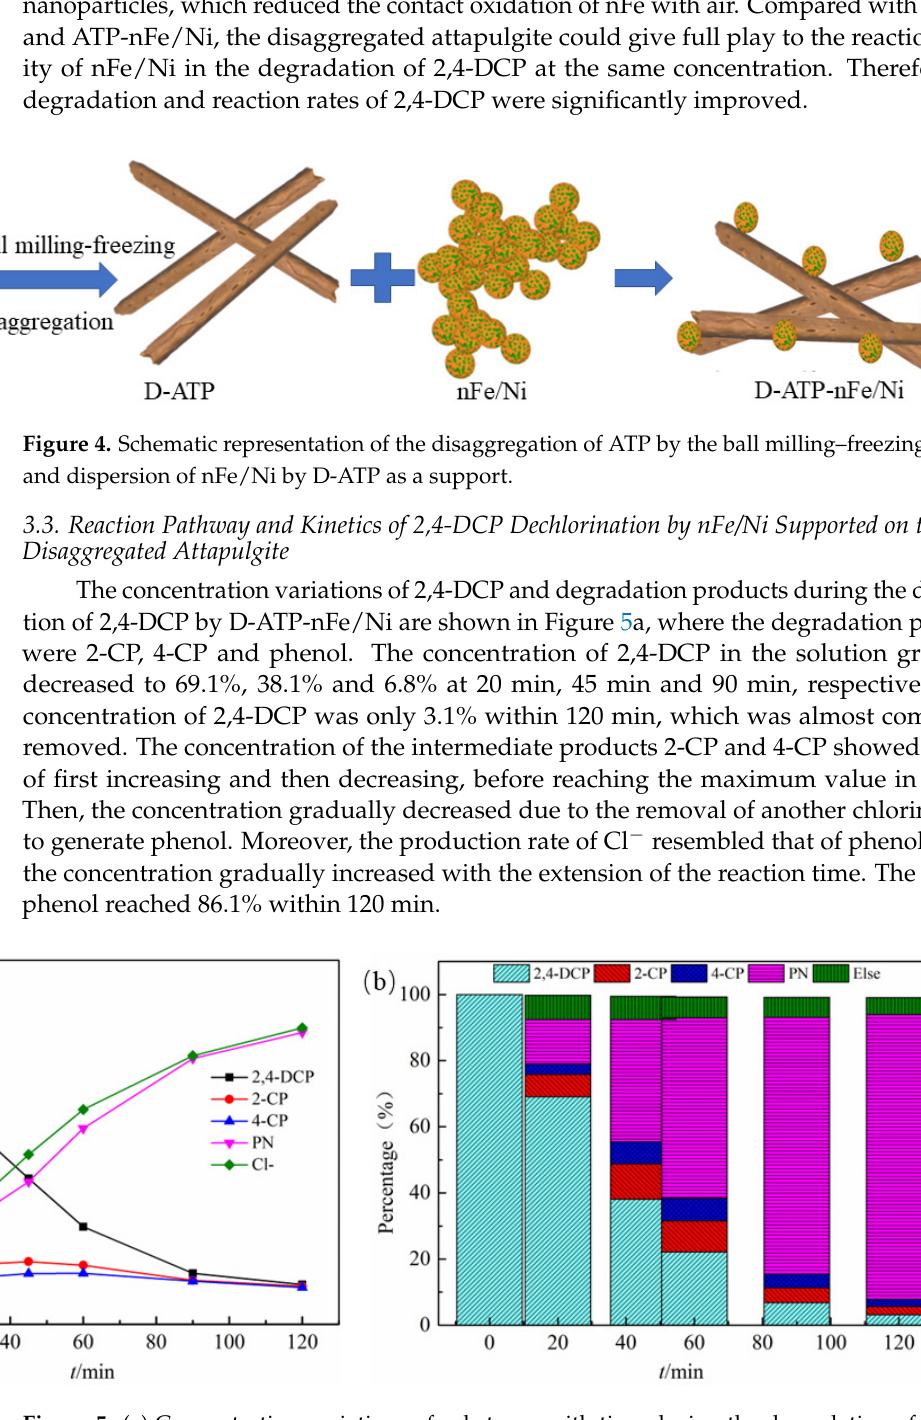
Figure 5. ( a ) Concentration variations of substance with time during the degradation of 2,4-DCP. ( b ) Mass balance analysis during the degradation of 2,4-DCP. ( b ) Mass balance analysis during the degradation of